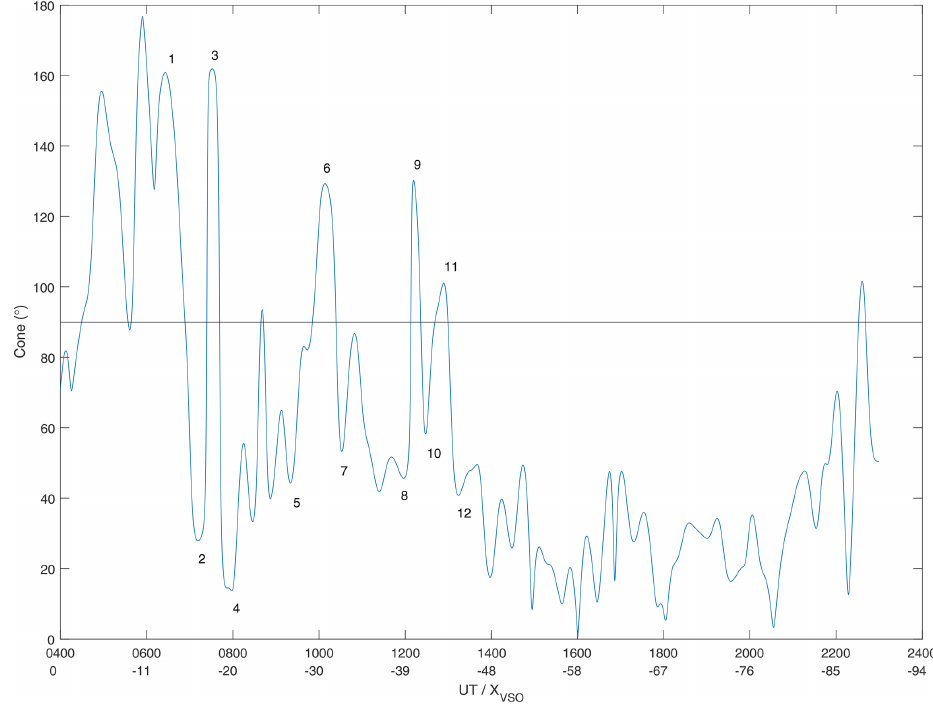
Figure 8. The cone angle of the magnetic field calculated from low-pass-filtered data, for periods longer than 30min, for the interval 04:00– 23:00UT. The numbered peaks are used to calculate the change in cone angle as BepiColombo moves from one lobe to the other, which is listed in Table 3. After 14:00UT the spacecraft is assumed to have left the magnetotail and to be in the solar